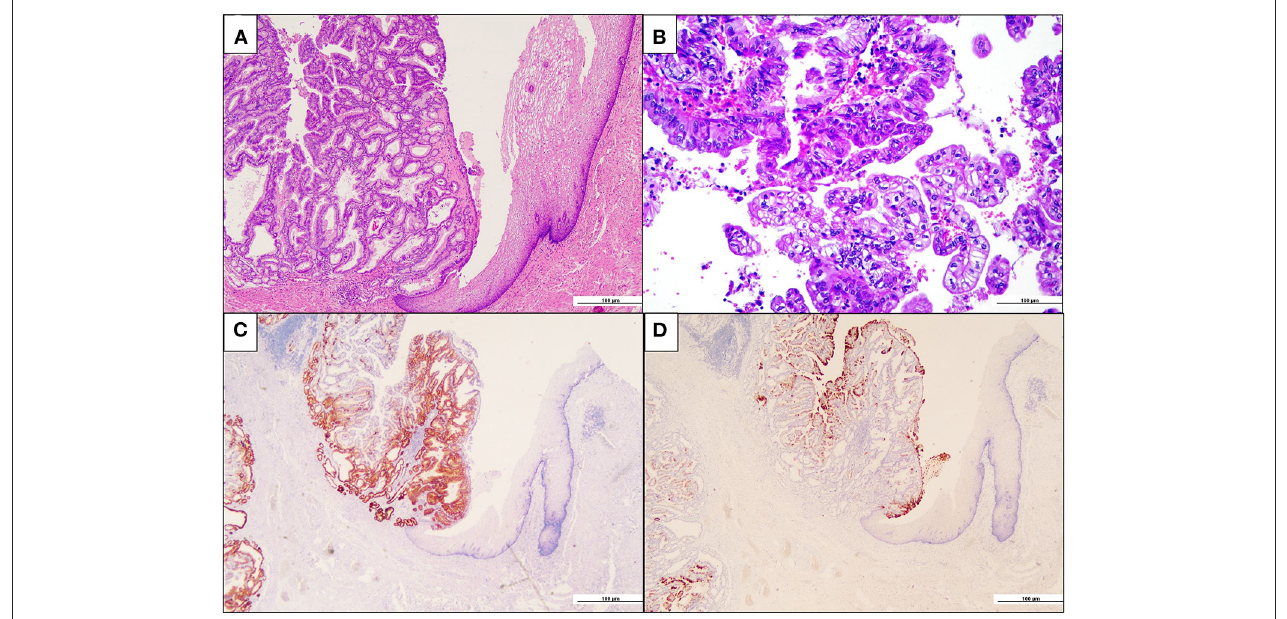
FIGURE 2 | Pyloric gland adenoma of the cardia. (A) The intramucosal neoplastic proliferation (on the left) is composed of closely packed glandular units. Note, on the right, the esophageal squamous epithelium (hematoxylin and eosin). (B) Focally, high-grade dysplastic features, with marked loss of nuclear polarity and complex papilary architecture, are seen (hematoxylin and eosin). (C) Neoplastic glands are diffusely immunoreactive for the pyloric gland marker MUC6 (MUC6 immunohistochemistry). (D) A superficial coating of MUC5AC-positive cells is appreciated, while the deeper glands are MUC5AC-negative (MUC5AC